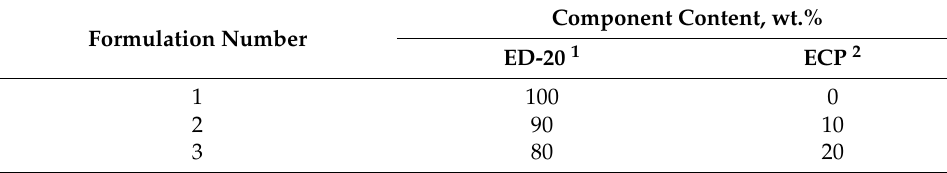
Table 1. The formulation of the mixtures. Formulation